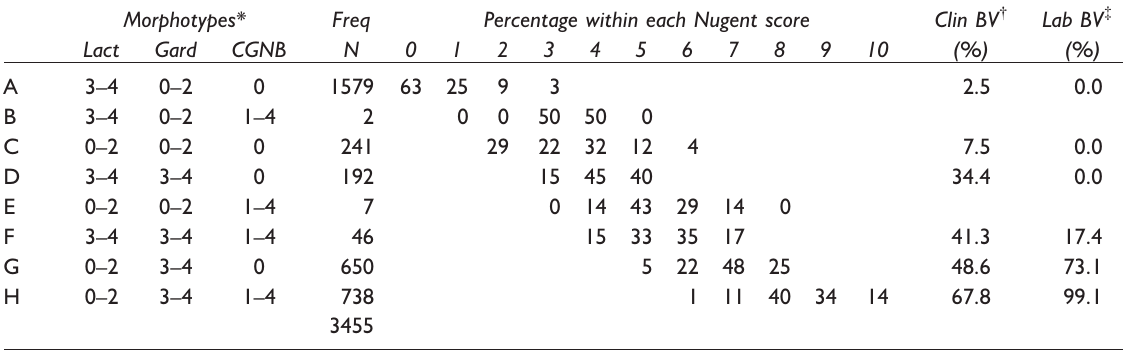
Table 1 Make-up of the morphotypic profiles and the percentage of each within the range of the Nugent scoring, clinical bacterial vaginosis (BV) and lab BV Morphotypes* Freq Percentage within each Nugent